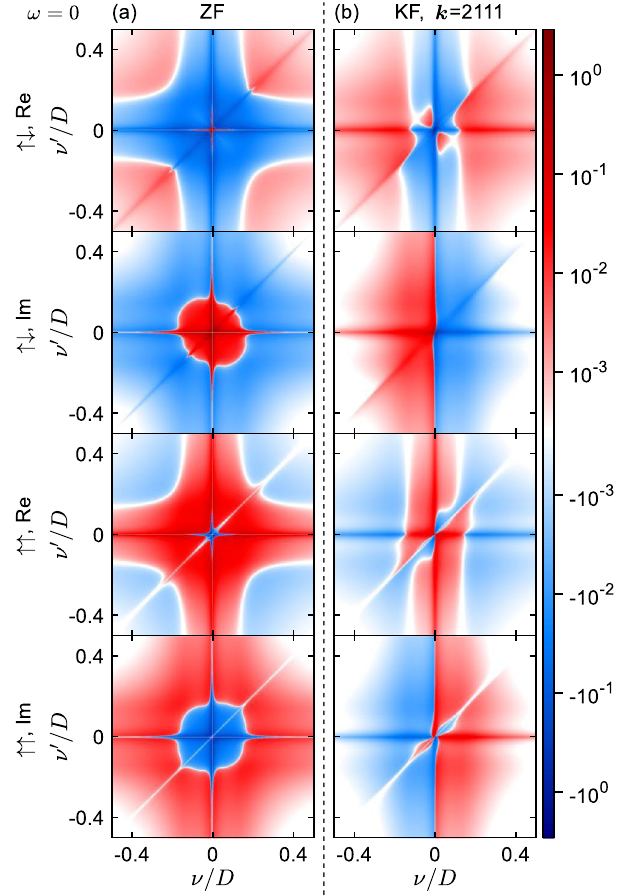
FIG. 6. Real-frequency correlators at strong coupling. (a) ZF and (b) KF ( k ¼ 2111 ) connected 4 p correlator, ð Δ 4 =U Þ G con σσ the strongly interacting AIM ( U= Δ ¼ 5 , Δ =D ¼ 1 = 25 , T ¼ 10 − 4 D , T =D ≃ 1 = 200 ). In both panels, the real-frequency K structure is much richer than that obtained at weak interaction (Fig. 5), and also than that of the imaginary-frequency MF results (Fig. 4) obtained for the same system